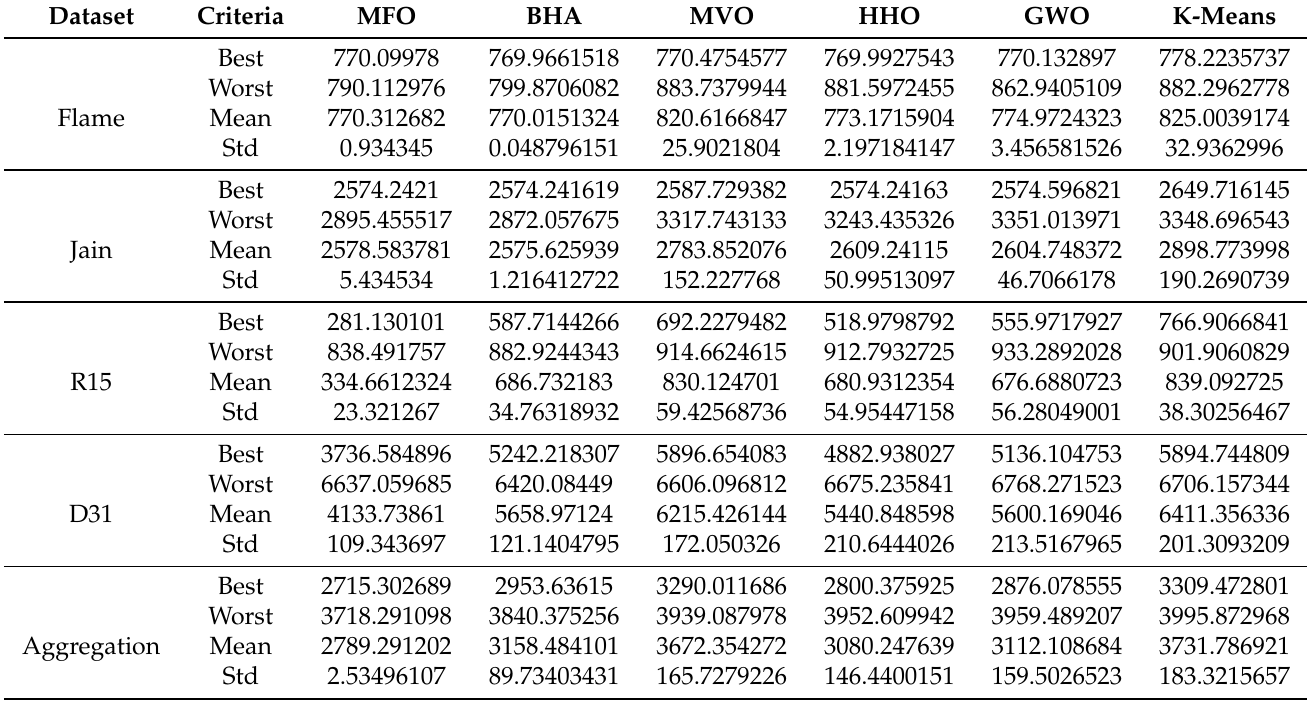
Table 3. Comparison of objective values of MFO, BHA, MVO, HHO, GWO, k-means algorithms.